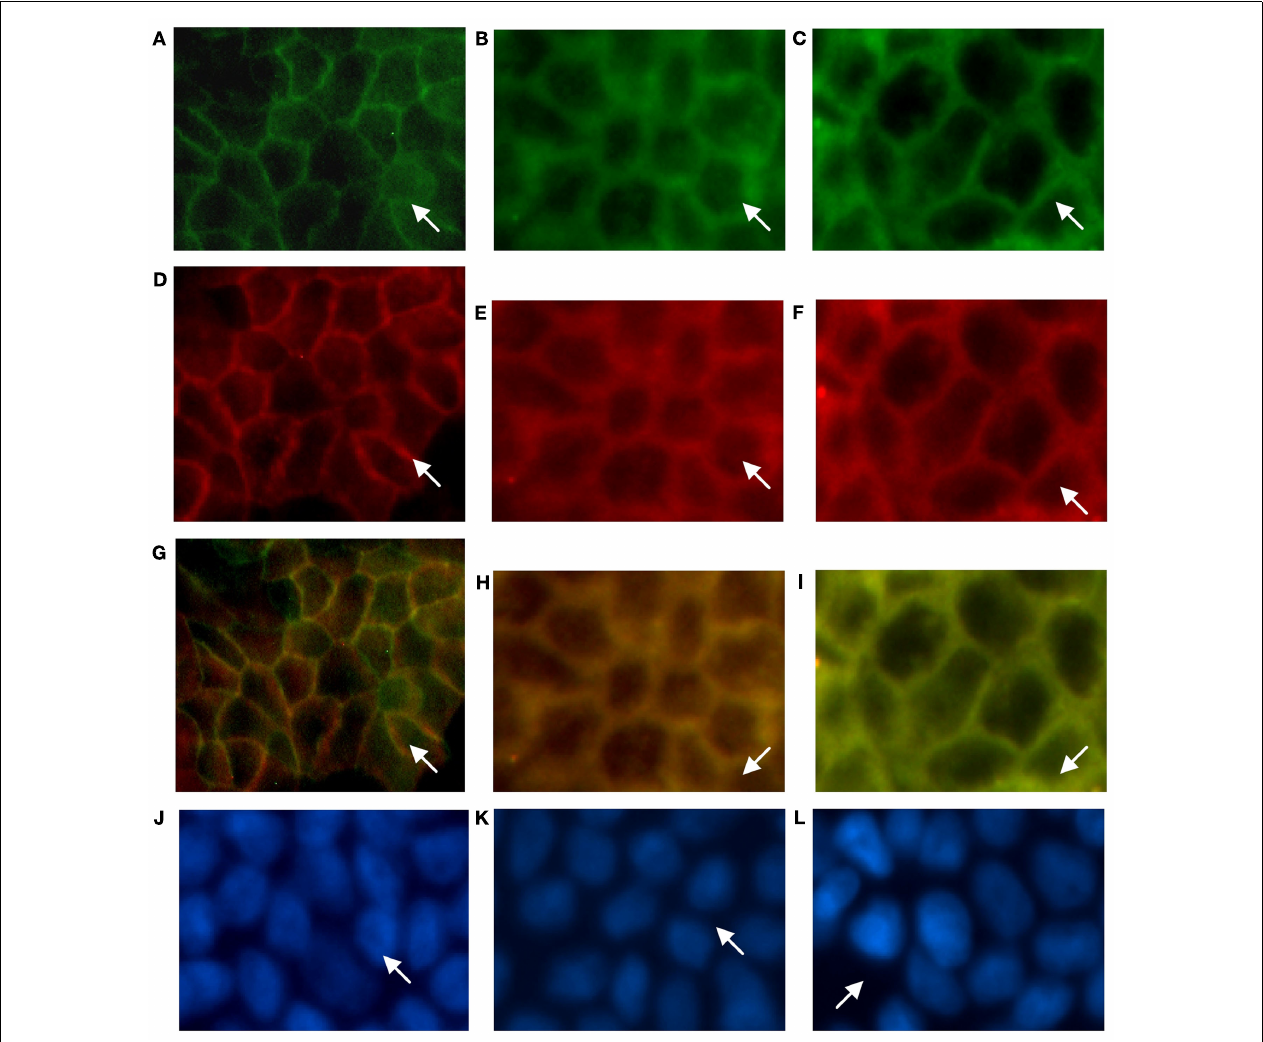
FIGURE 2 | Effects ofAFM 1 treatment on Caco-2/TC7TJ complex components ZO-1 and occludin and nuclear structure. No differences between control and treated monolayer was observed (arrows). (A–C) ZO-1 labeling, (A) control monolayer, (B) monolayer treated with 1,000ng/kg AFM 1 for 1h, (C) monolayer treated with 10,000ng/kg AFM 1 for 1h, (D–F) Occludin labeling, (D) control monolayer, (E) monolayer treated with 1,000ng/kg AFM 1